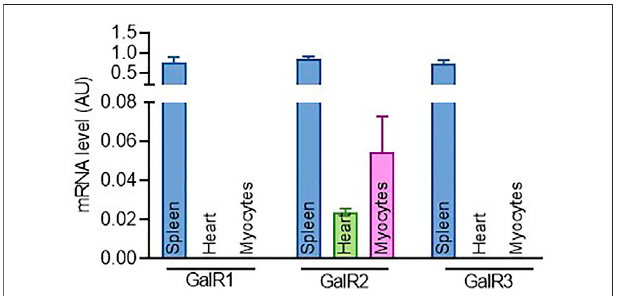
FIGURE1 | Expression pro fi ling of GalR1, GalR2 and GalR3 in cardiac tissues and cells. The expression level of GalR1, GalR2 and GalR3 mRNA in mouse spleen, heart and primary cardiomyocytes. Data are presented as the mean ± SEM from at least three independent